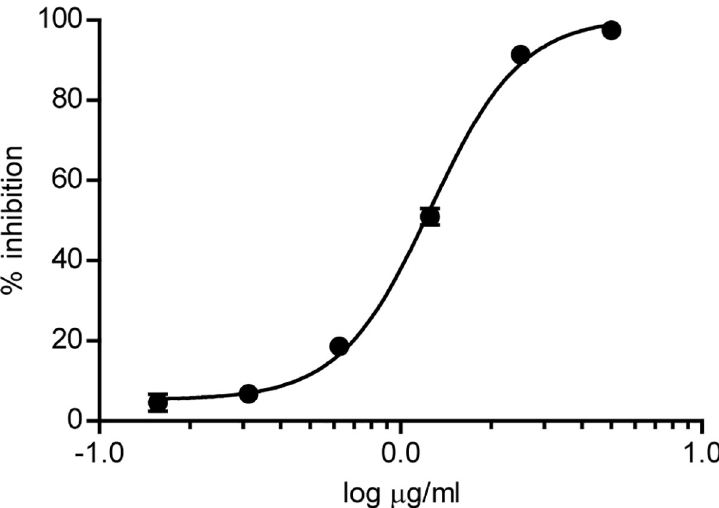
Fig 5. Standard curve for the detection of ZNS1 by indirect competitive ELISA with 1F5 mAb. Standard curve of the icELISA to detect denatured ZNS1 using 1F5 mAb, calculated with a 4 parameter logistic regression fitting with the following equation: Y = Bottom + (Top-Bottom)/(1+10^((LogEC50-X) � Hill slope)), where Bottom = 5.28, Top = 100.6, EC50 = 1.26 and Hill slope = 2.87. Each point of the curve represents mean ± SEM of six sample replicates.